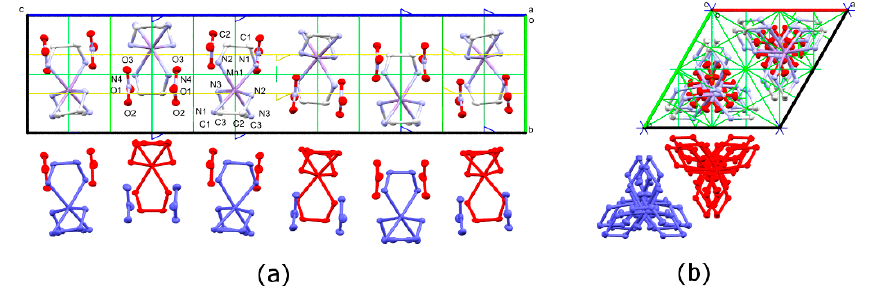
Figure 2. Representation with anisotropic displacement ellipsoids at 50% probability of Λ -[Mn(en) 3 ](NO 3 ) 2 at 120 K as viewed down the ( a ) a crystal axis and ( b ) c crystal axis. Unit cell and symmetry axes are shown, with blue = six-fold screw, yellow = three-fold, and green = two-fold. Hydrogen atoms have been omitted for clarity.